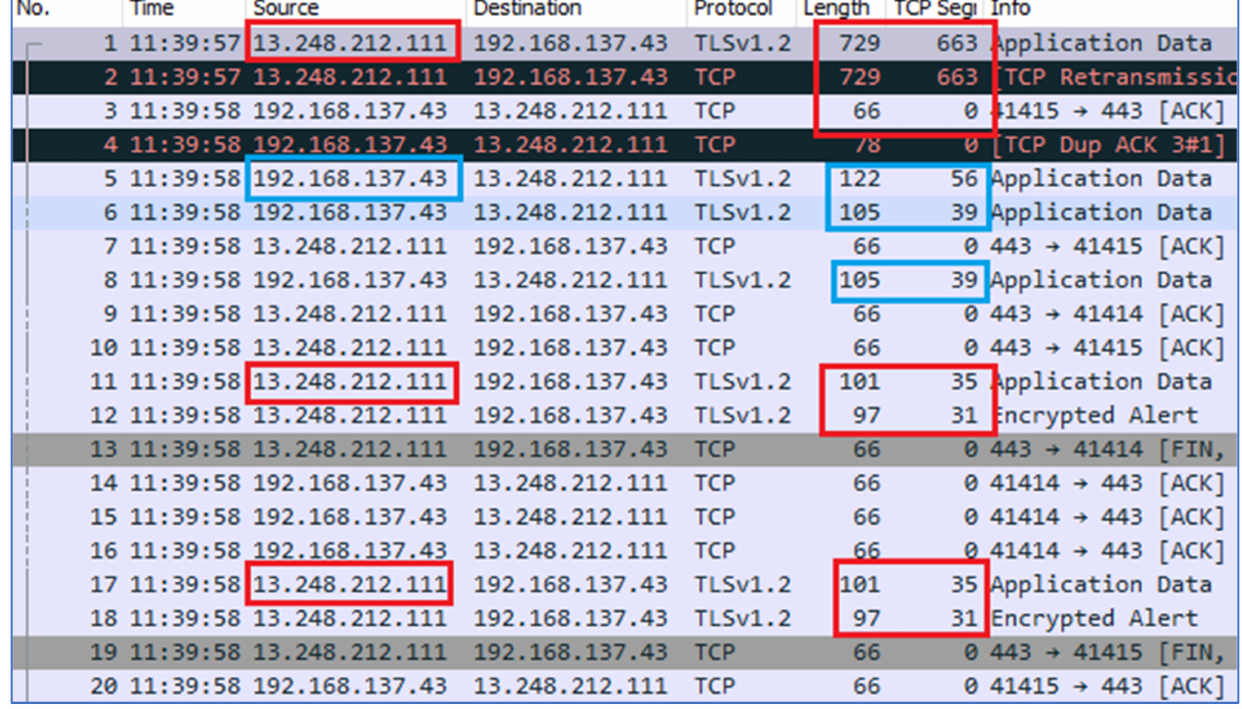
Figure 8. User B message typing and